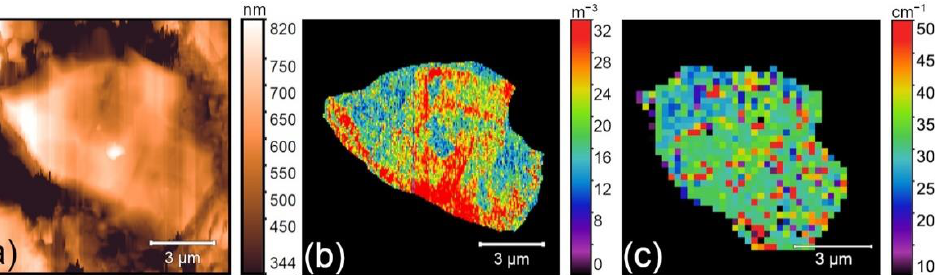
Figure A1. Correlative ESM and CRM measurements performed on the active particle of fresh Li 0.6 Mn 2 O 4 . ( a ) Topography, ( b ) lithium ion concentration, and ( c ) FWHM of A1g Raman peak.